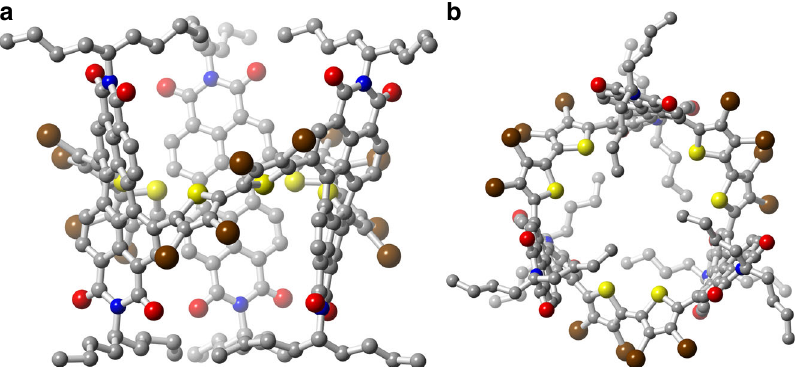
Fig. 2 Molecular structure from SCXRD of 1 -Br 12 . a Side and b top view of ( SSS )- 1 -Br 12 . C, N, O, S, and Br atoms are colored in gray, blue, red, yellow, and brown, respectively. Hydrogen atoms have been removed to clarify the view. The alkyl chains on the imide are re fi ned to only nine of the eleven carbon atoms due to disorder (see